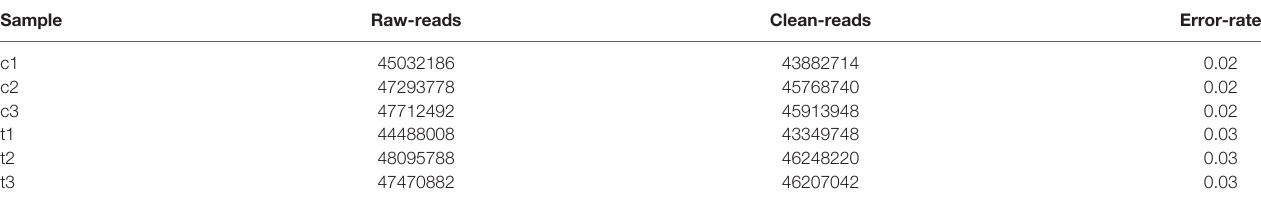
TABLE 3 | Transcriptome data QC results.